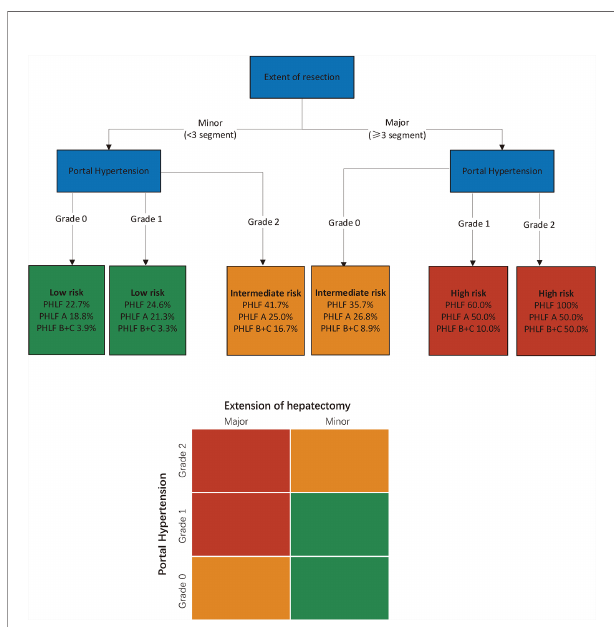
FIGURE 3 | Multi-parametric assessment of the risk of PHLF in patients with hepatocellular carcinoma. Simpli fi ed decisional algorithm identifying high (red), intermediate (yellow) and low (green) risk of PHLF, according to a hierarchic interaction of the two independent risk factors: portal hypertension, and extent of resection. Major hepatectomy, hepatectomy range at least 3 liver segments; minor hepatectomy, hepatectomy range less than 3 segments. PHLF, post hepatectomy liver